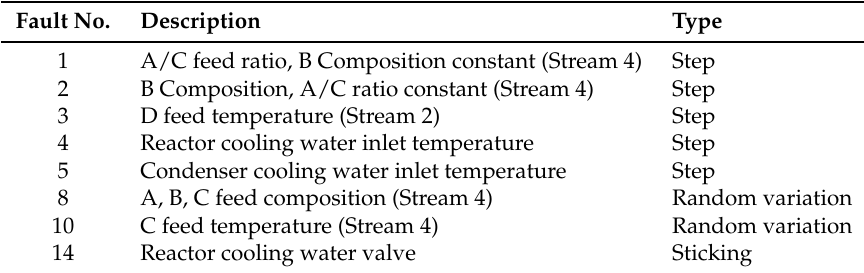
Table 1. Faults that can be implemented in Tennessee Eastman Process simulator, reproduced with permission from [32]. Copyright Elsevier, 2004.